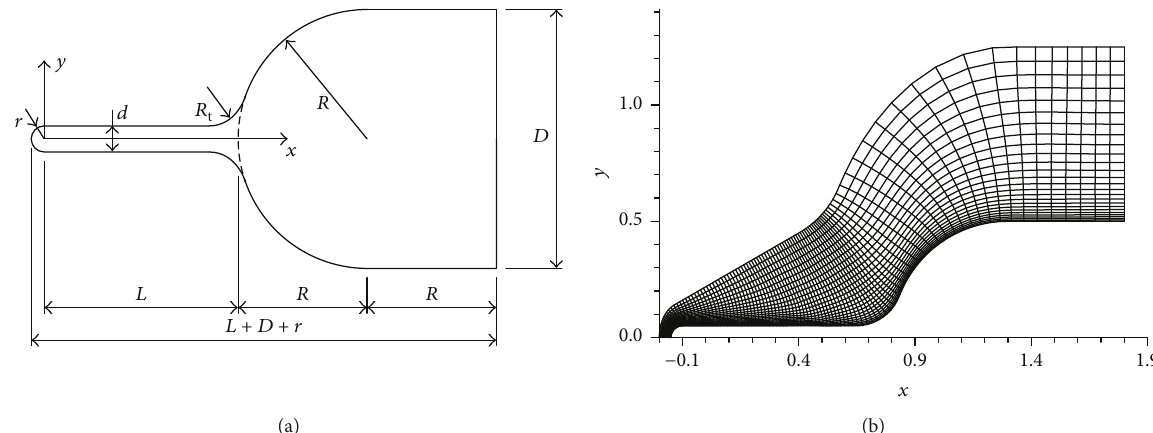
Figure 1: (a) Con fi guration of the spiked blunt body for simulation. (b) Grid system for the spiked blunt body with spike length of L / D